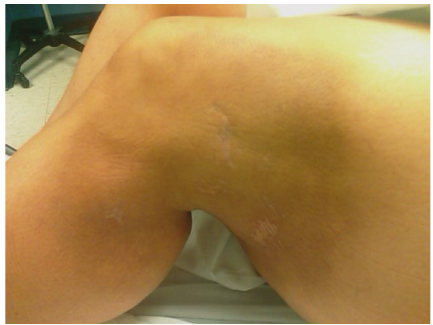
Figure 3: Cutaneous lesions after treatment with five cycles of CHOP chemotherapy (Five months after second